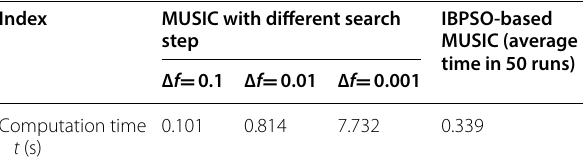
Table 5 Specifications of the test